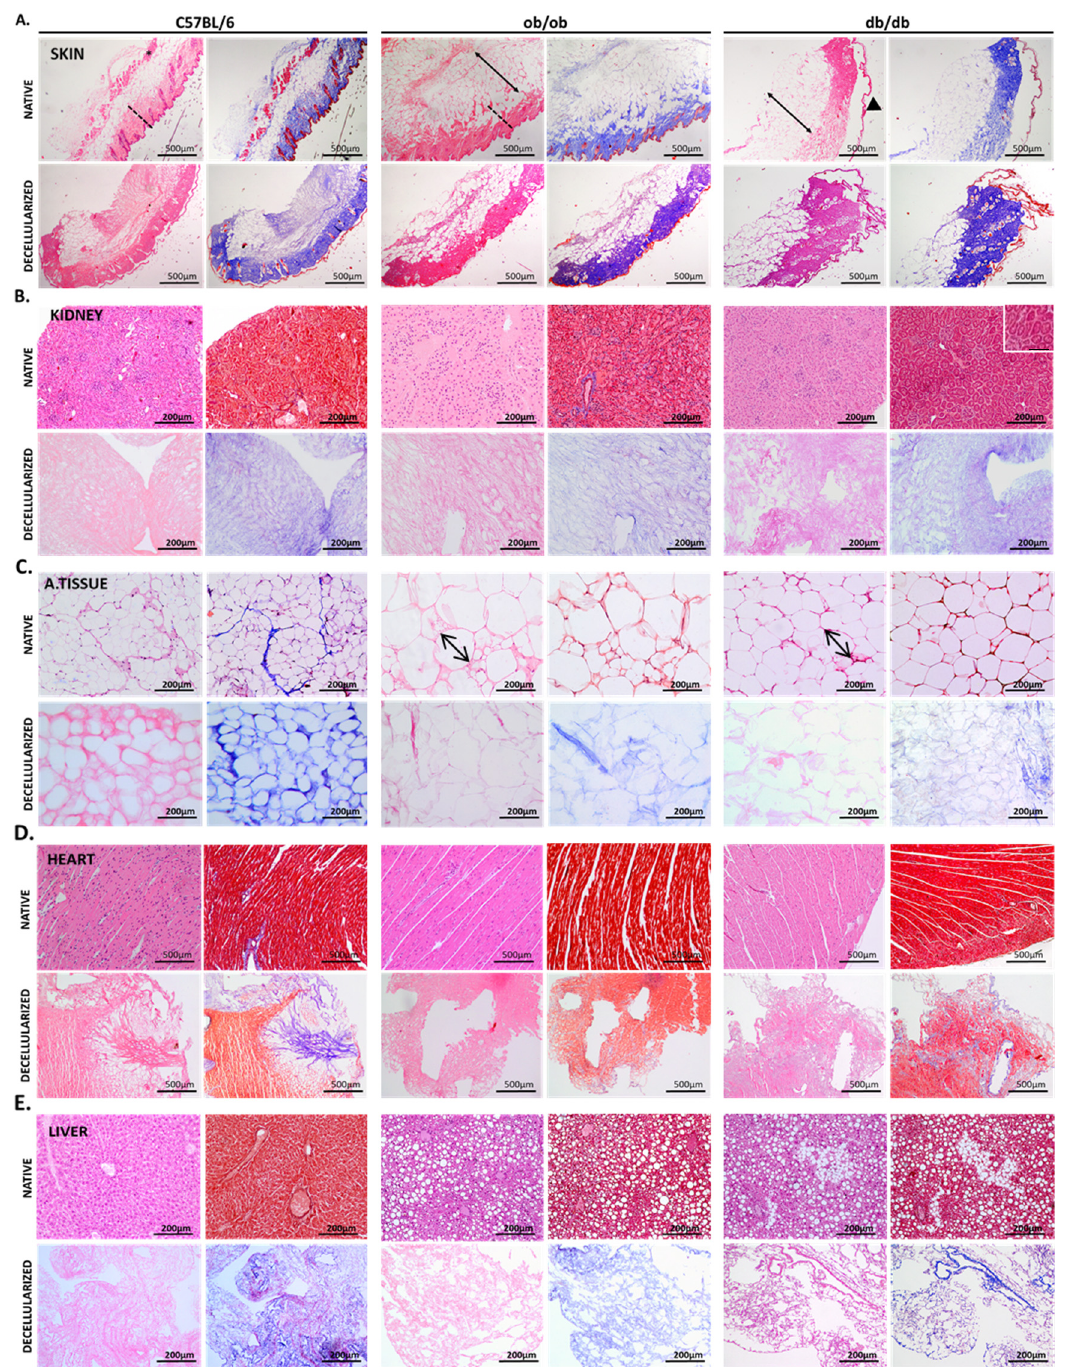
Figure 2. Native tissues of transgenic mice strains present evident histological alterations; however, ECM scaffolds are equally maintained after decellularization. Optical microscopy micrographs of native (upper panels) and decellularized (lower panels) tissue sections. Representative images of skin ( A ); kidney ( B ); adipose tissue ( C ); heart ( D ) and liver ( E ) samples obtained from C57BL/6J, ob/ob, and db/db animals. Depicted are histology H&E (left panels) and Masson’s Trichrome (right panels) stainings, with scale bars included in each image (200 or 500 µm as indicated, and 100 µm in the inset). Asterisk, skin muscle layer; thin arrow, skin adipose layer; dashed line, skin dermis; arrowhead, epidermis; bold arrow, adipocyte hypertrophy.